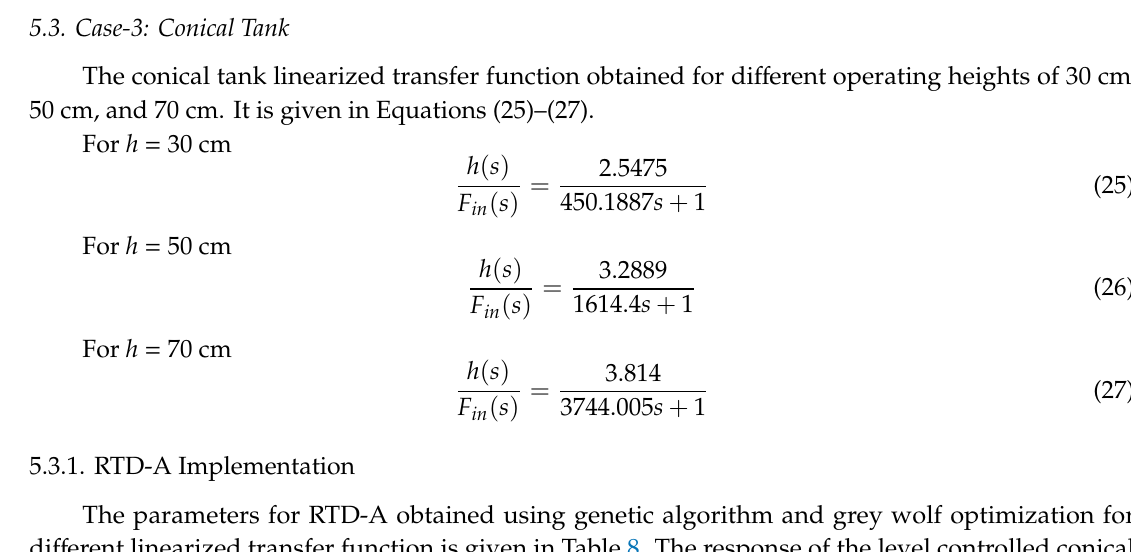
Figure 9. Case-1: Performance comparison chart between RTD-A and PID.